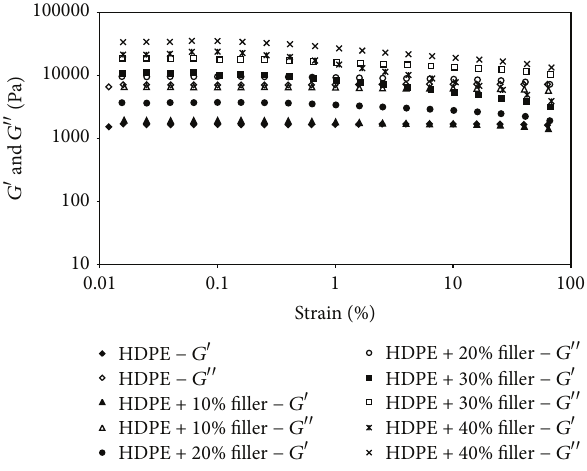
Figure 2: Strain sweep results for neat renewable HDPE and its composites containing different wt% of sponge gourd filler.